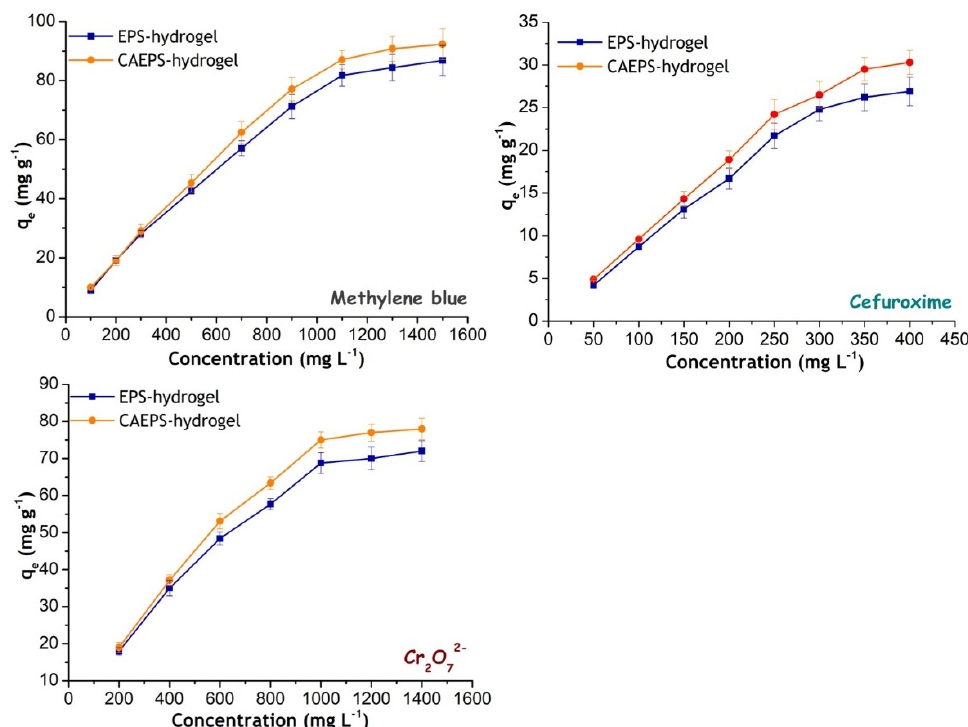
Figure 9. The static adsorption schematic diagram of EPS- and CAEPS-hydrogel on methylene blue.